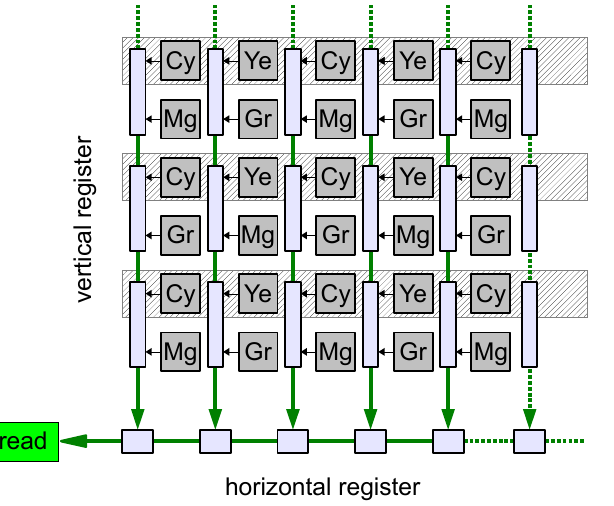
d) optimal “raw” mode: max duty cycle = T/(T+t), overlap=(T-t)/T